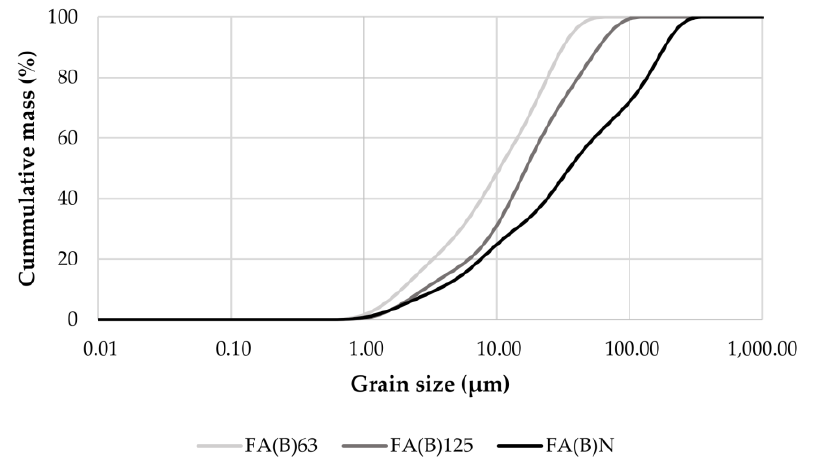
Figure 2. Grain size distribution of fly ash sieved with 63 µm (FA(B)63) or 125 µm (FA(B)125) sieve compared with untreated fly ash (FA(B)N). Table 5. Physical properties of sieved fly ash (FA(B)63 and FA(B)125) compared with untreated fly ash